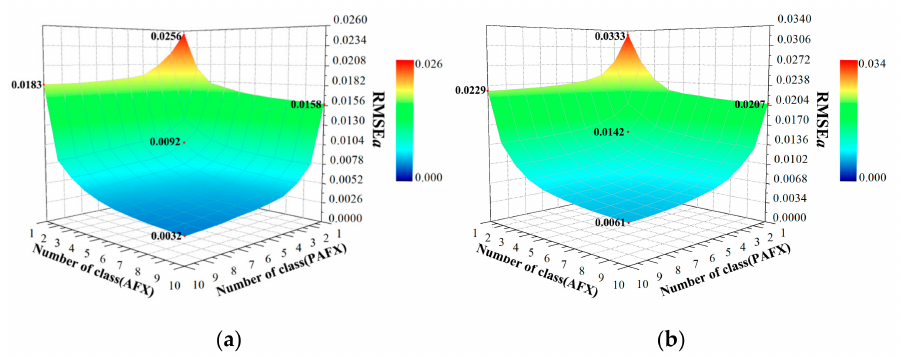
Figure 4. The changes in RMSE a with the number of classifications in the red band ( a ) and the NIR band ( b ). The x -axis and y -axis refer to the number of AFX- and PAFX-based classes. The z -axis refers to the value of mean fitting error. The colors refer to the magnitude of RMSE a .